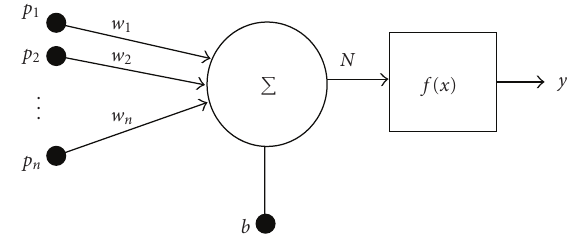
Figure 2: An artificial neuron